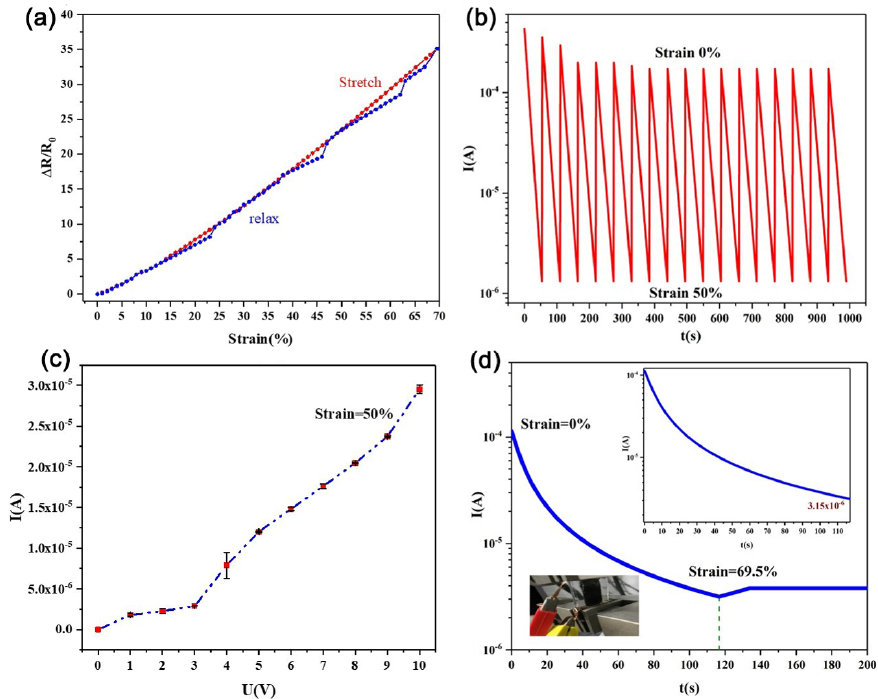
Figure 6. Sensor performance of Fe NW ‐ based flexible tensile strain sensor: ( a ) the hysteresis performance of the sensor when it is stretched to 70%, ( b ) the repetitive performance of the sensor when it is repeatedly stretched from 0 to 50%, ( c ) when the sensor is stretched to 50%, as the voltage increases, the sensor output current changes, and ( d ) sensor output current response.